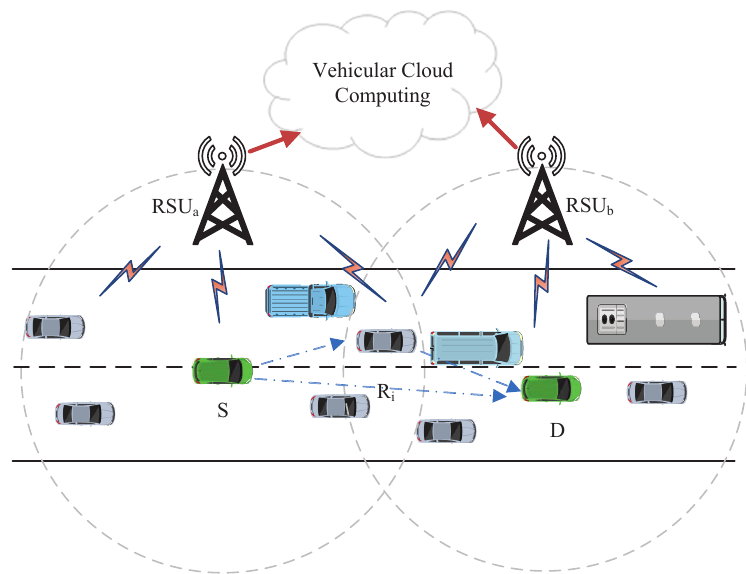
Figure 1. The system model where vehicle S attempts to transmit a message to vehicle D